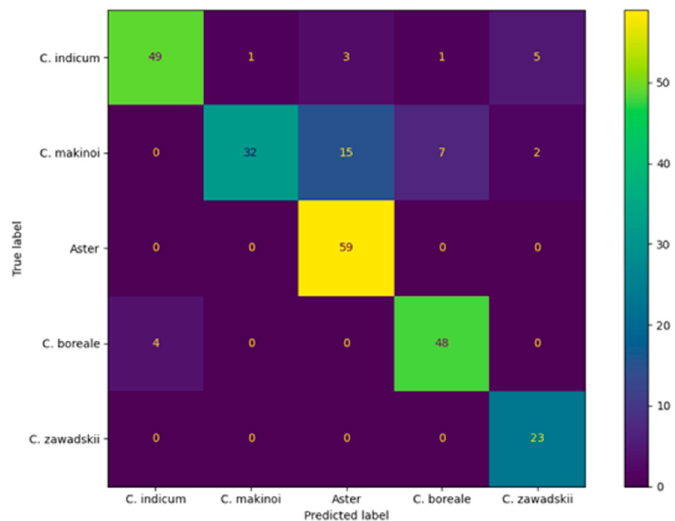
Figure 4. Confusion matrix on the testing dataset using the trained model.